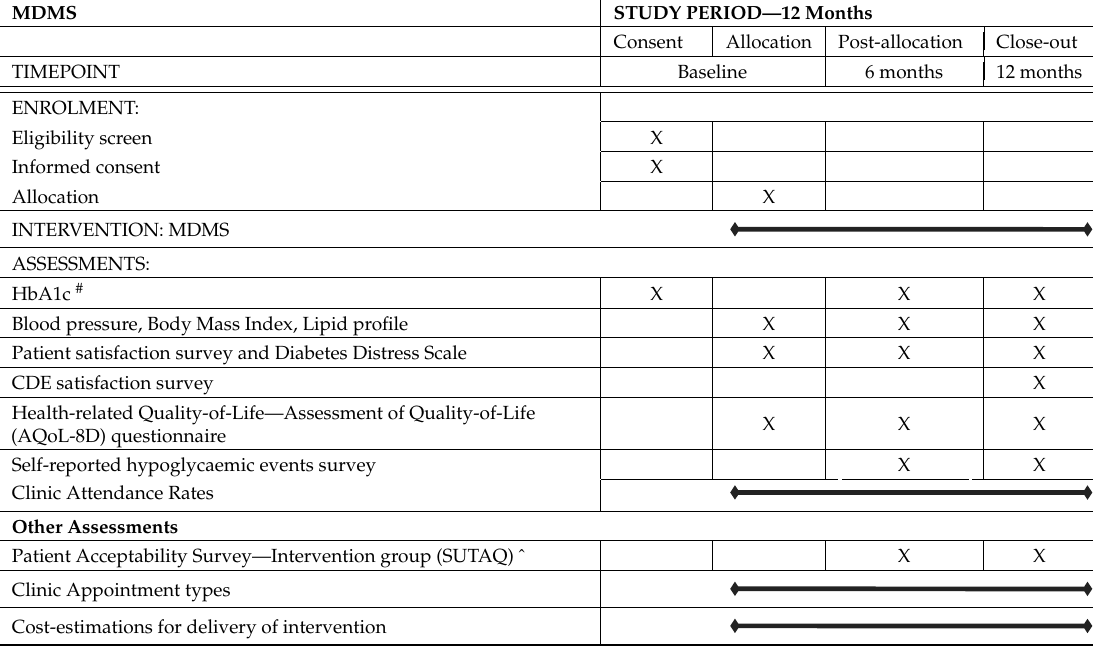
Table 1. Schedule of Enrolment, Intervention and Assessments.